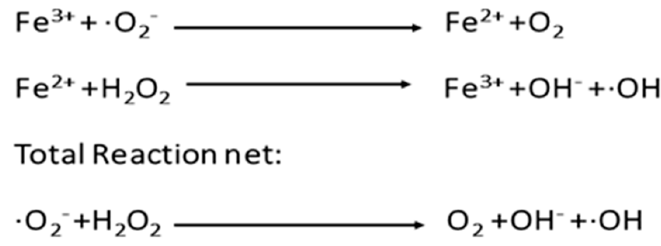
Figure 3. Haber–Weiss Reaction and Fenton reaction.